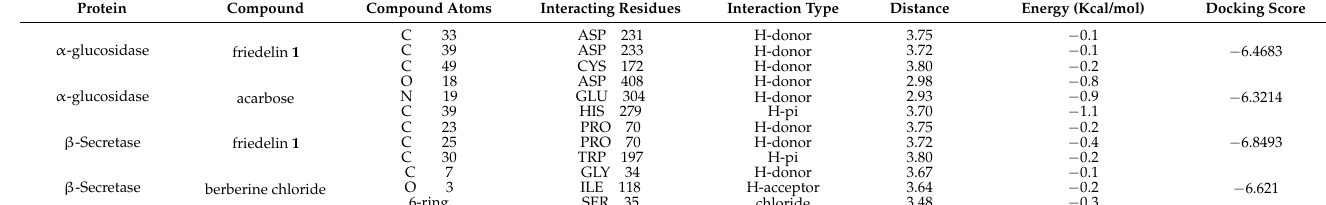
Table 4. Docking score and interactions of all the receptors with the isolated compound.